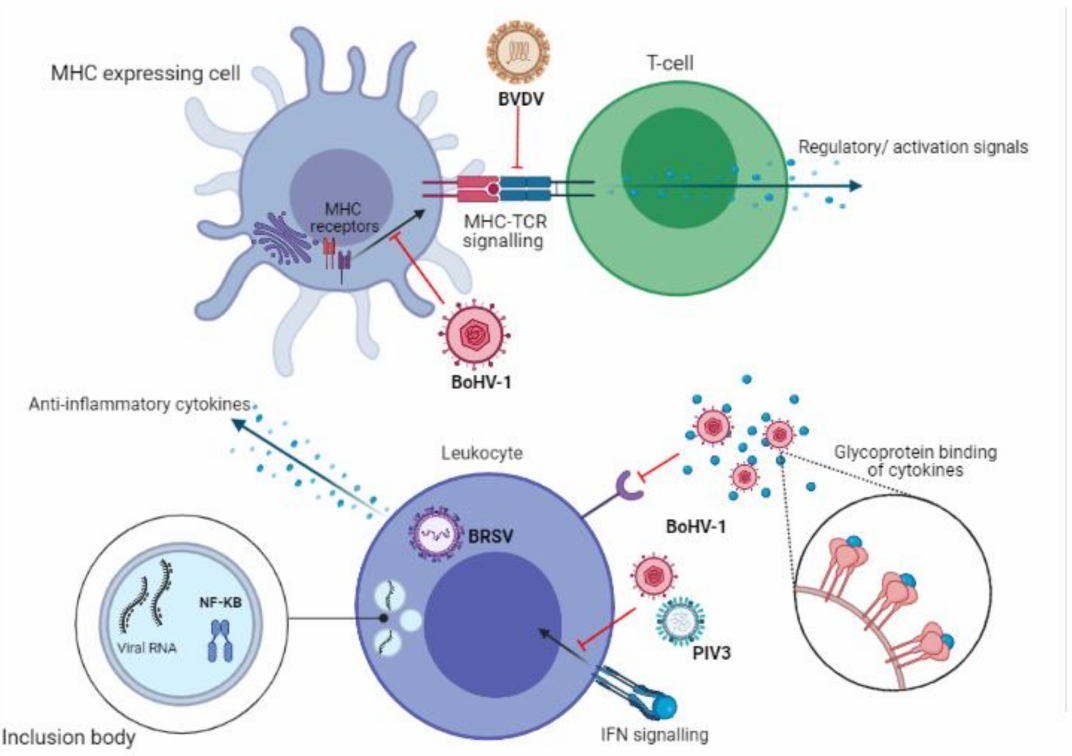
Figure 3. Inter- and intra-cell signalling dysregulation induced by bacterial and viral infections. Interferences with MHC protein expression and cytokine regulation result in limited anti-viral and bacterial immune responses and poor immune memory production. (Created in BioRender.com, accessed on 24 March